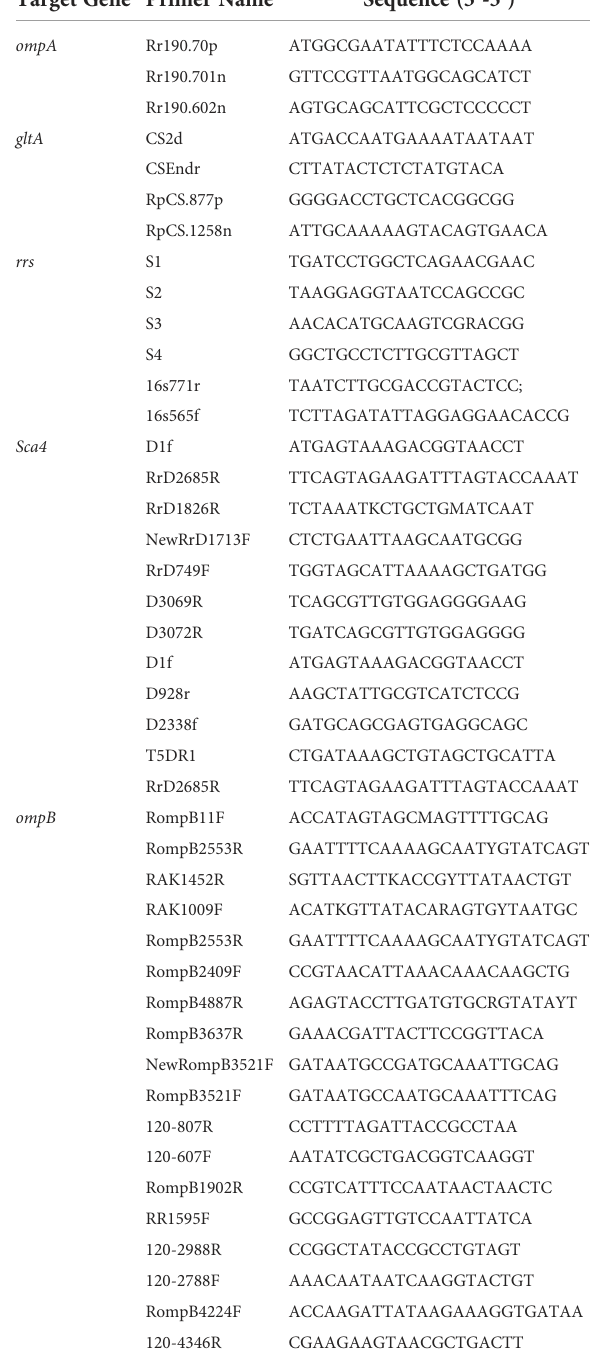
TABLE 1 Primers used for PCR ampli fi